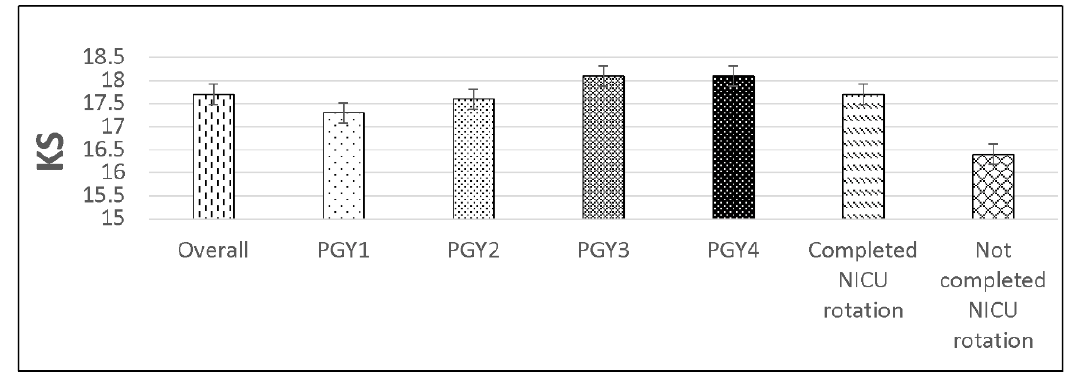
Figure 1. Knowledge score (KS) by level of training ( p = 0.001) and NICU rotation ( p < 0.001).